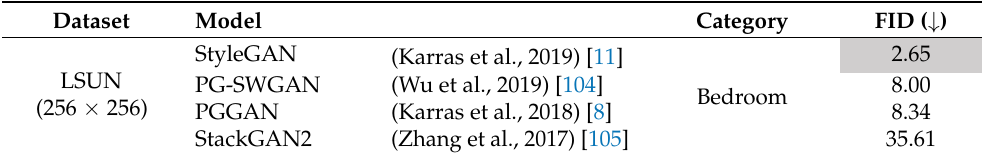
Table 11. The FID of different models trained on the LSUN bedroom dataset. The lower the FID value, the better the